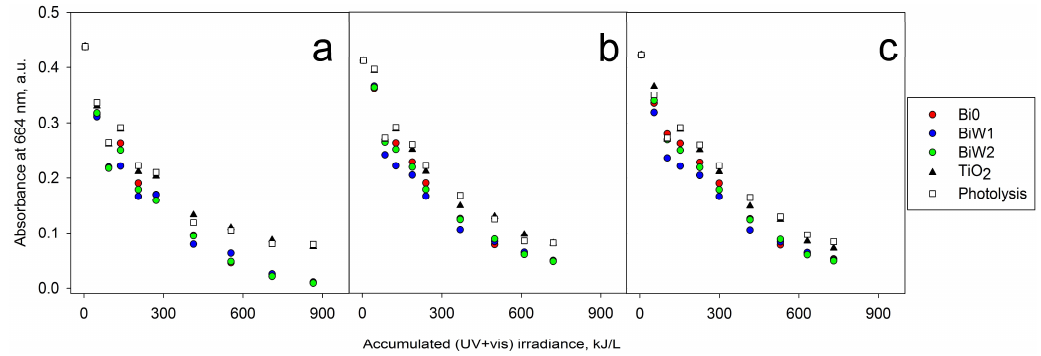
Figure 10. MB absorbance decay at 664 nm as a function of the accumulated global (UV + VIS) irradiance for three rounds of the experiments.